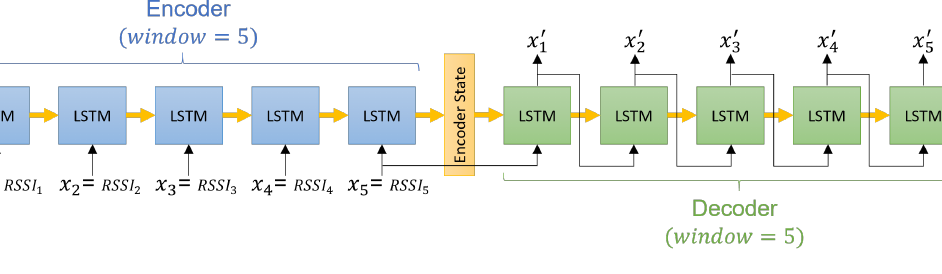
Figure 3. Anatomy of the LSTM